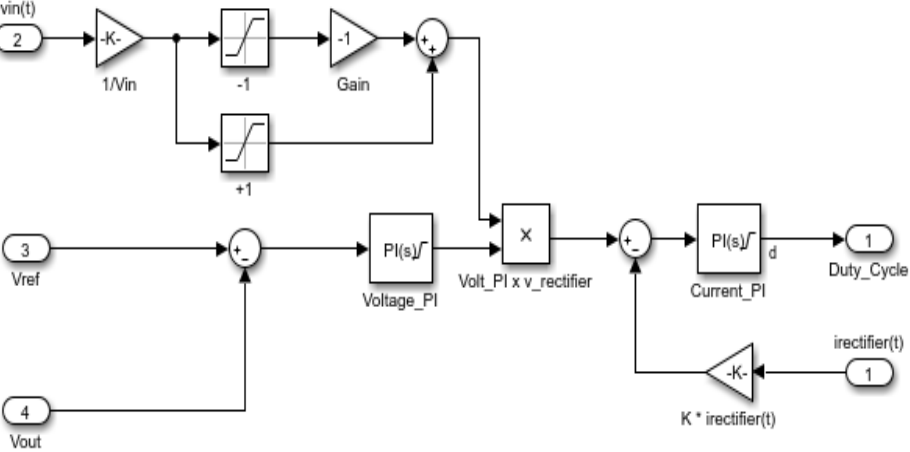
Figure 5. MATLAB Simulink inside “PFC” sub-system. K—Current calibration factor.